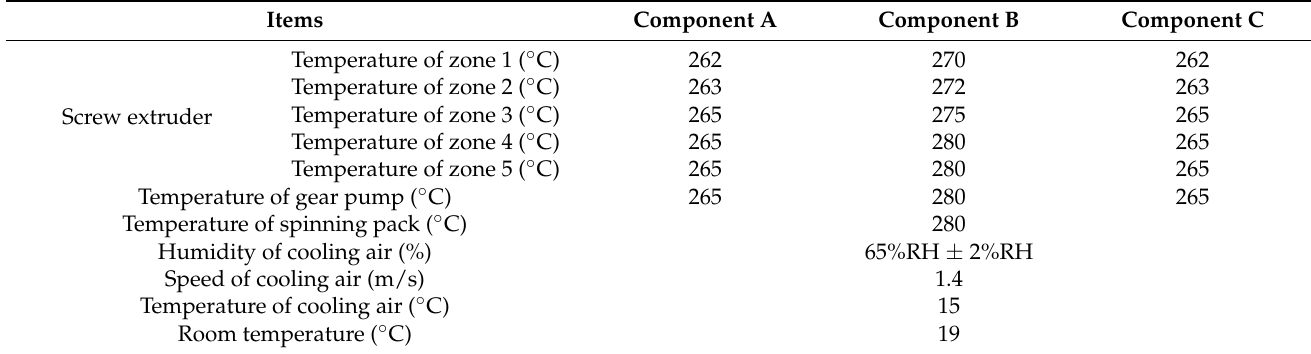
Figure 7. The schematic diagram of the melt spinning equipment. Table 3. Spinning process parameters of fiber with “fishbone” cross -sectional pattern.